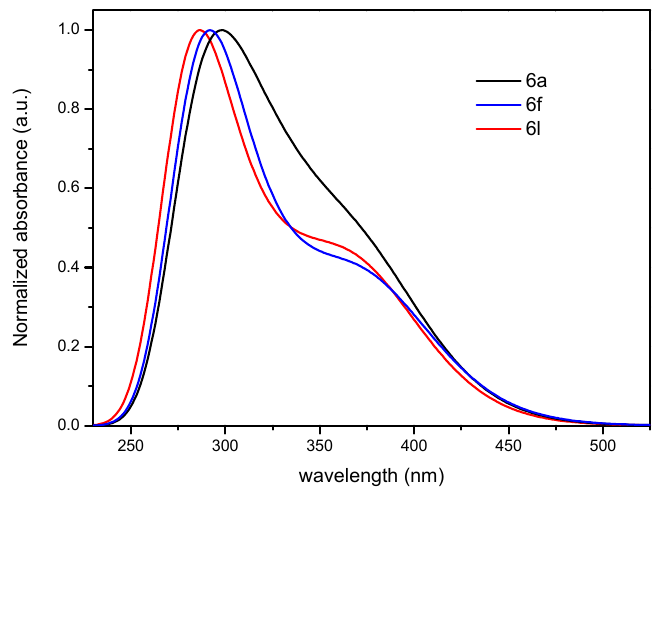
Figure 11. The computed electronic absorption spectra of 6a , 6f and